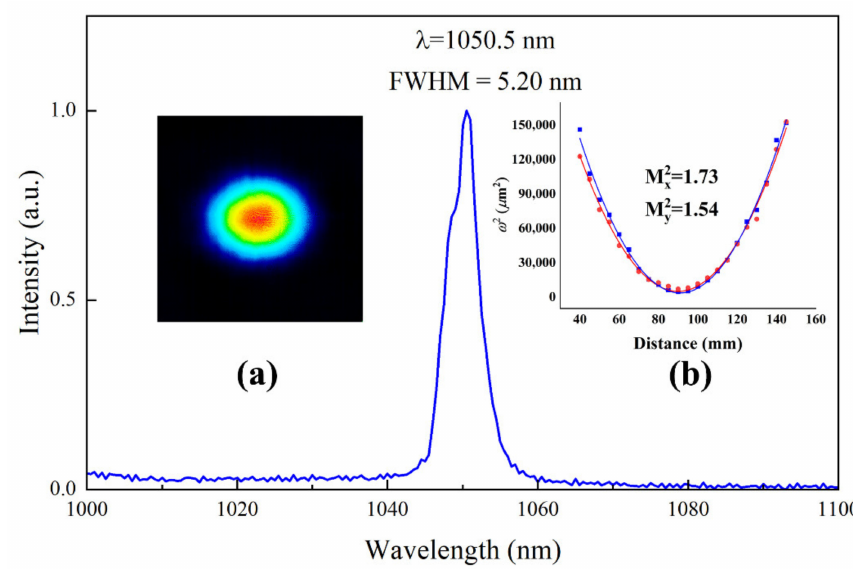
Figure 6. Pulsed laser spectrum. Insert ( a ): laser beam profile. Insert ( b ): M 2